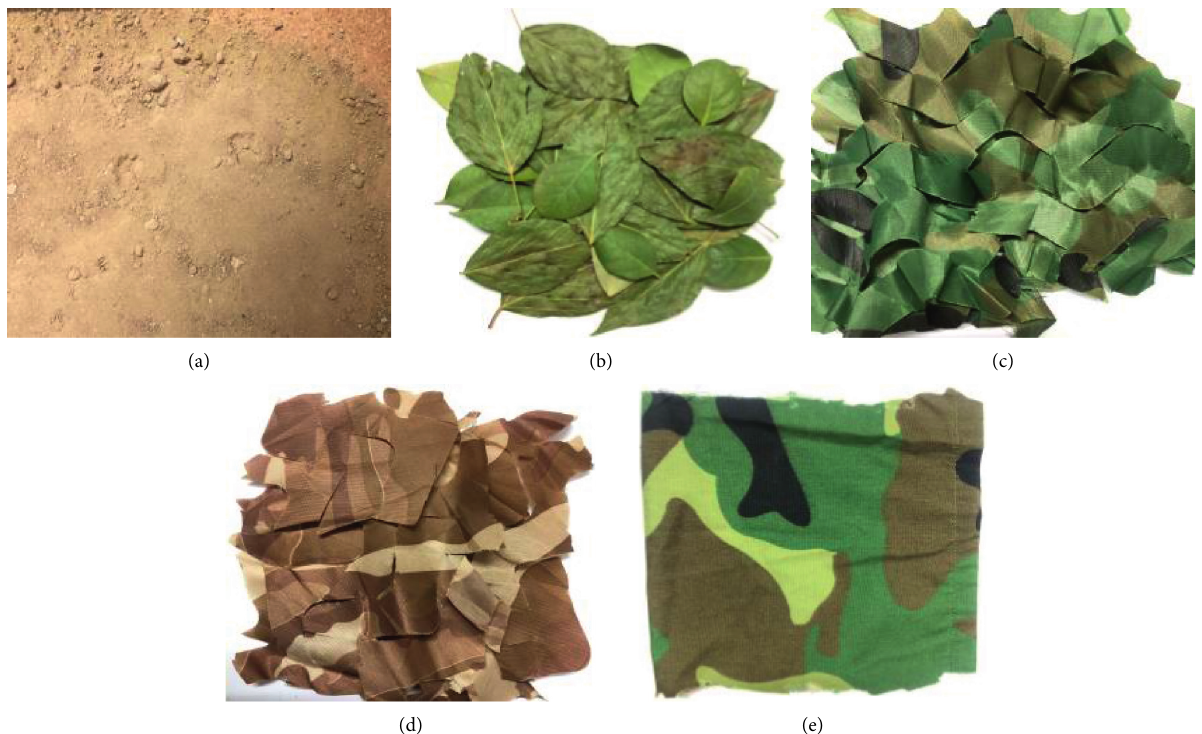
Figure 4: True colour images of samples. (a) An actual sand table. (b) Forest leaves. (c) Jungle camouflage netting. (d) Desert camouflage netting. (e) Jungle camouflage